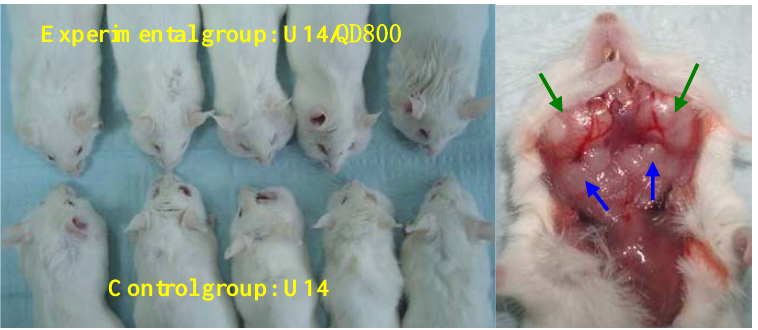
Figure 3. Buccal cancer cervical lymph node metastasis model. Green arrows point to buccal tumors and blue arrows point to enlarged lymph nodes.